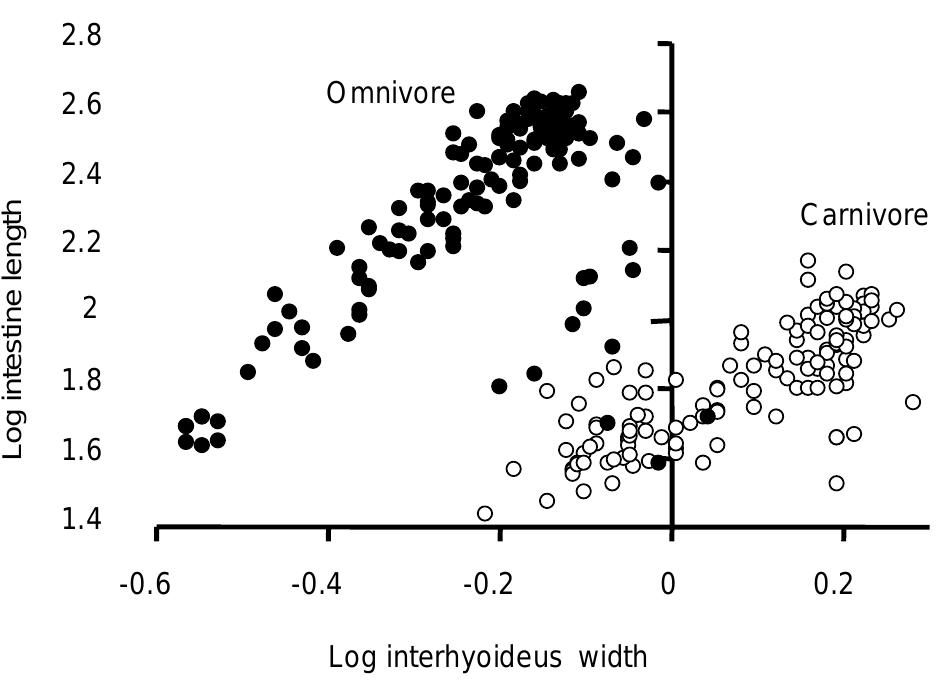
FIGURE 4. Log intestine length plotted against log interhyoideus width for carnivores (open symbols) and omnivores (filled symbols). Carnivore and omnivore phenotypes are distinctly different until convergence at metamorphic